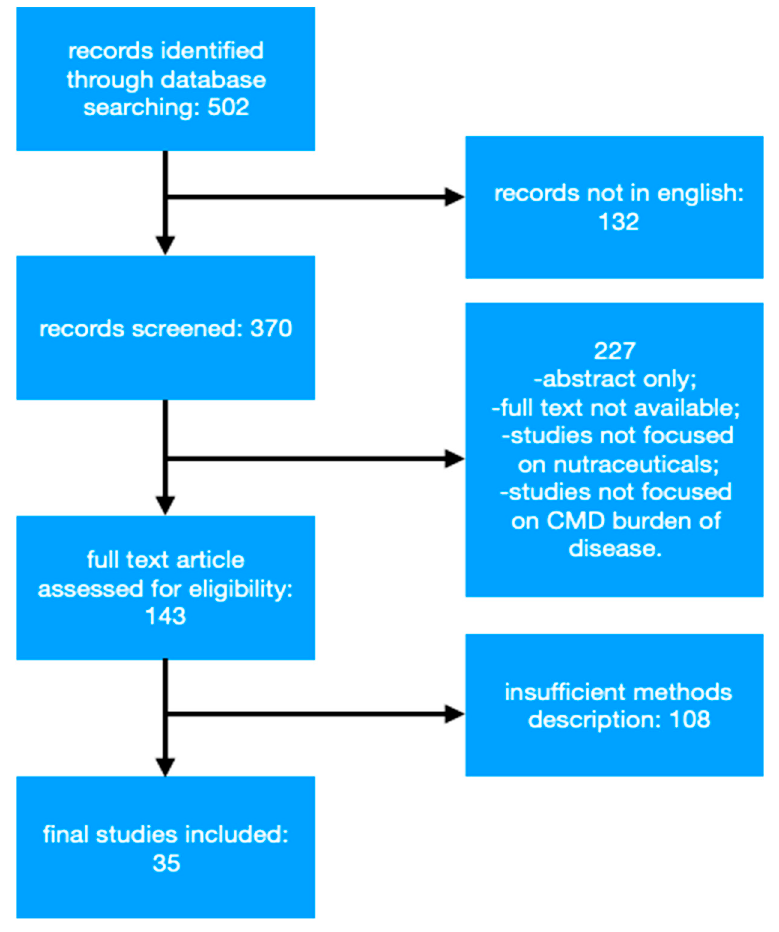
Scheme 1. Flow diagram on the studies’ selection process